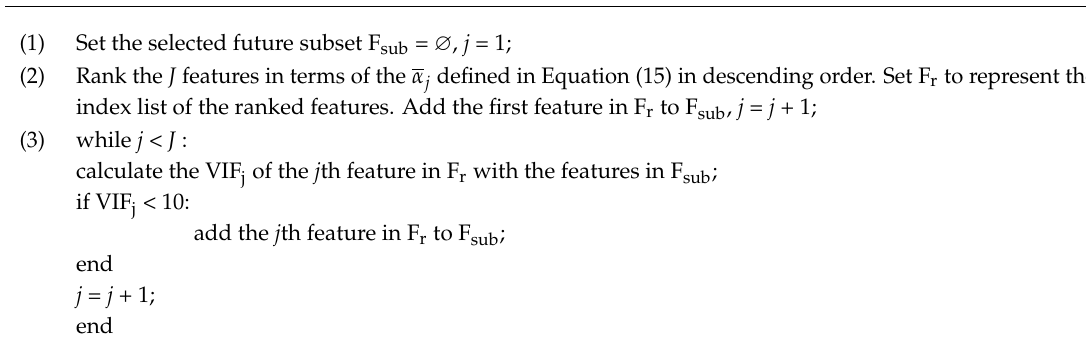
Algorithm 1: MDV